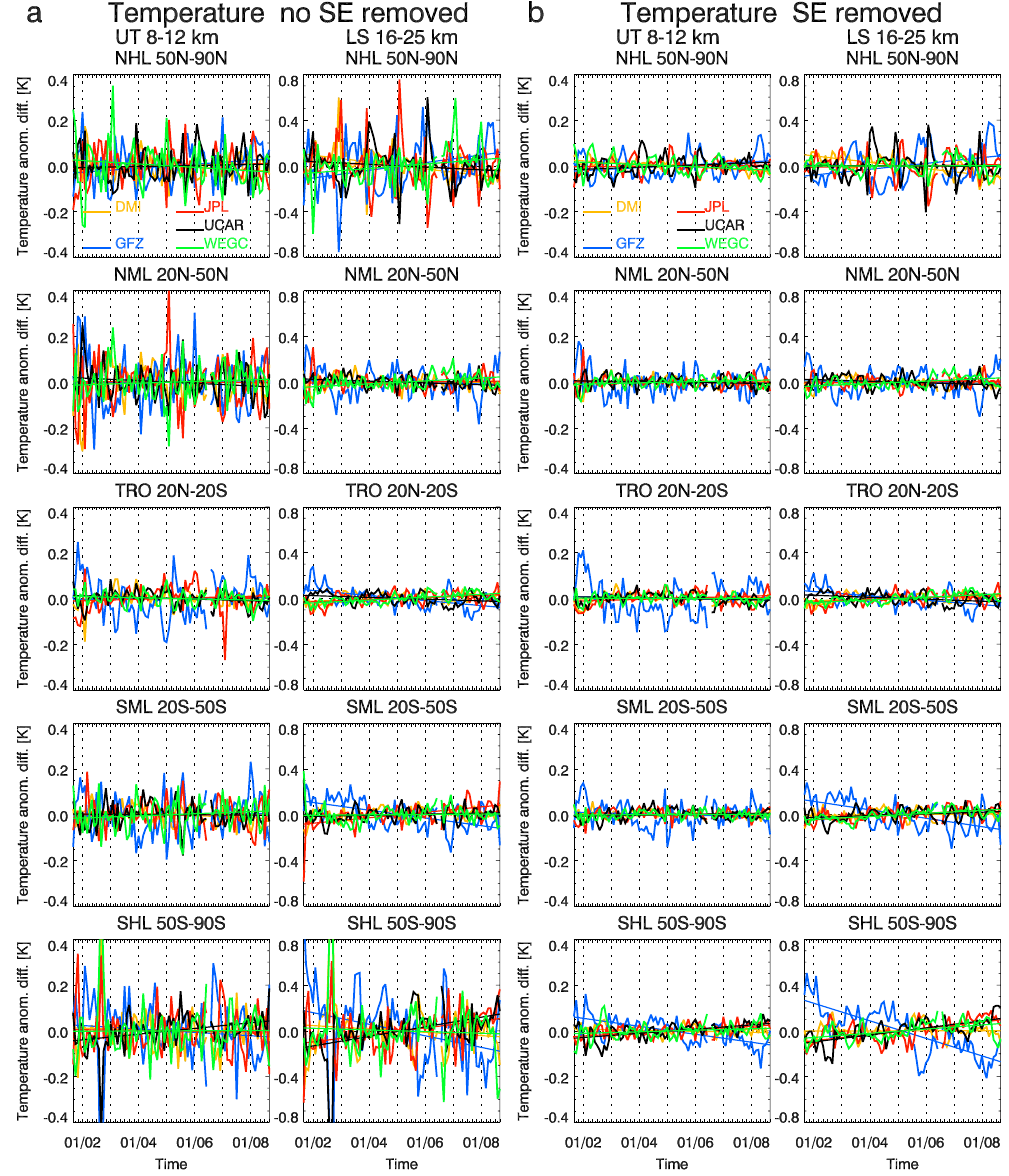
Fig. 3. De-seasonalized anomaly difference time series and trends of (a) temperature and of (b) temperature where sampling error was subtracted, shown for the (left) UT and (right) LS for (top to bottom) five zonal regions. Note the different y-axis for the UT and the LS